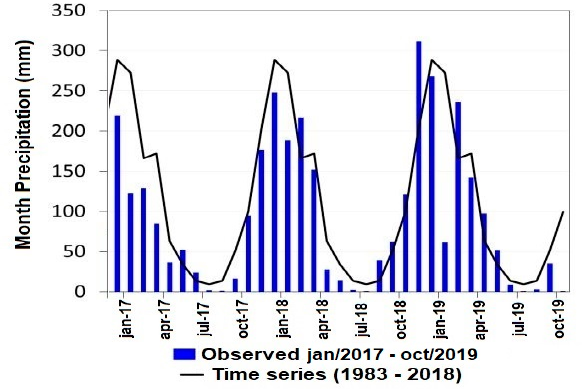
Figure 15. Monthly accumulated rainfall precipitation time series for Três Marias’s reservoir catchment. Source: Adapted from [30].